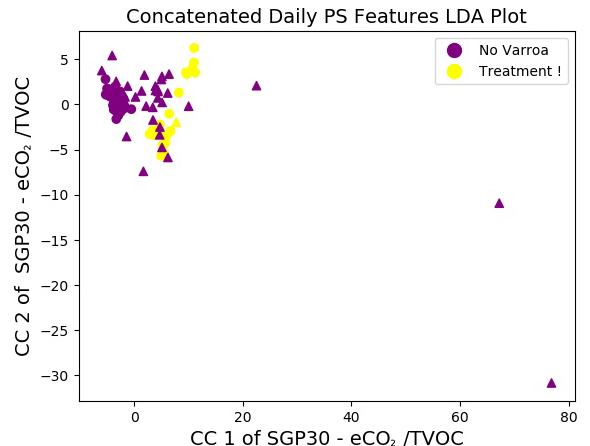
Figure 10. Scatterplot of the tlength feature for the SGP30 eCO 2 and TVOC outputs for cross classification of the July–September (circles) and additional May–June (triangles) campaigns with two classes of VILE.